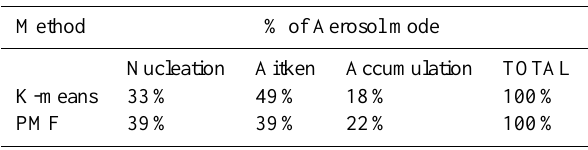
Table 5. Summary of mode decomposition K-means clustering and PMF